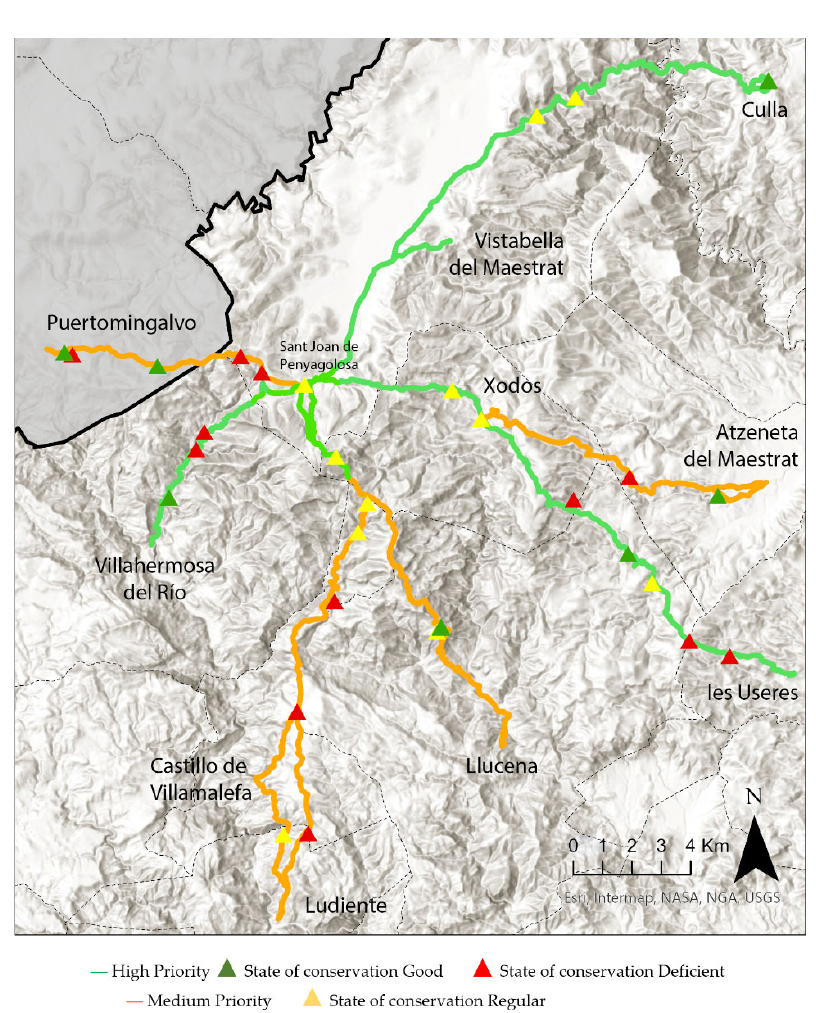
Figure 8. The prioritised itineraries are: medium (orange) and high (green), and the state of conservation of the other cultural assets is: good (green), regular (yellow), and deficient (red).